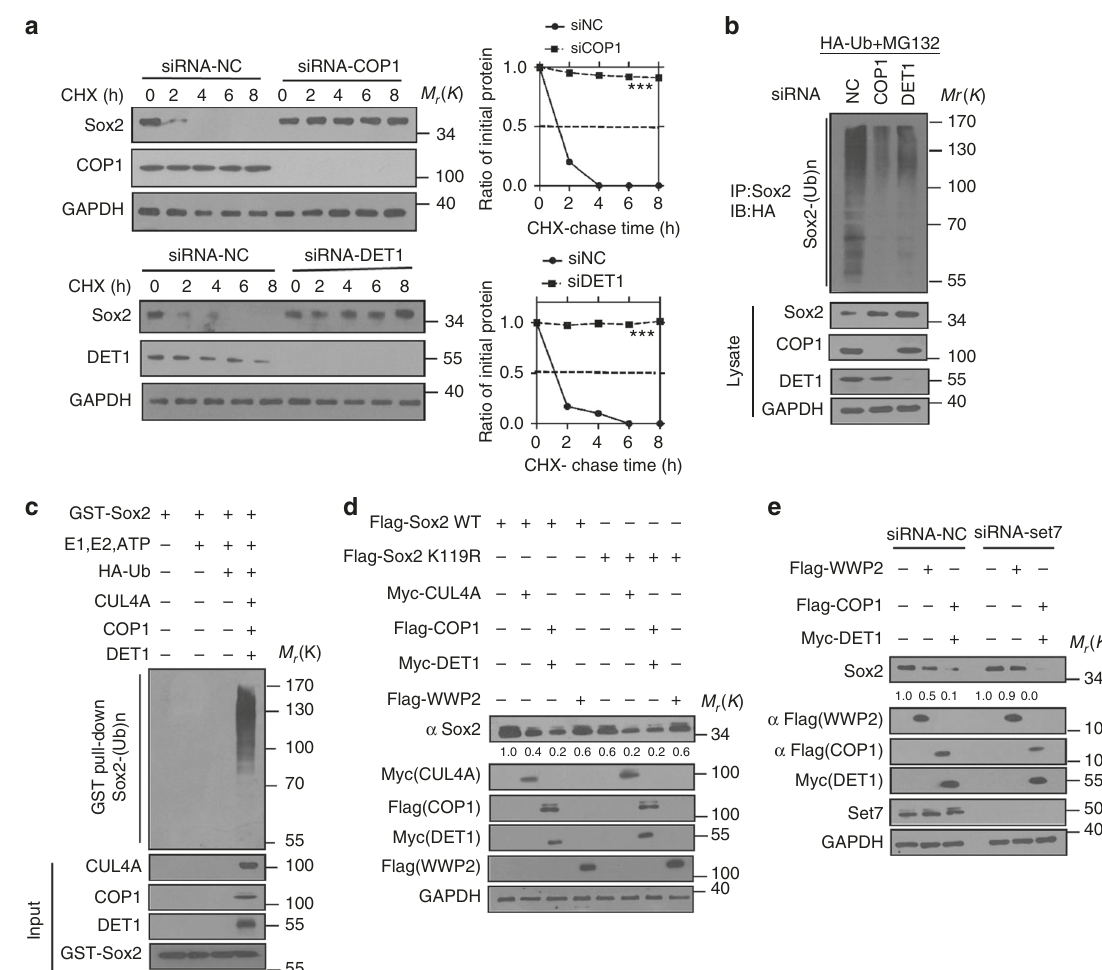
Fig. 4 CUL4A DET1-COP1 ubiquitylates SOX2. a HEK293T cell line with knockdown of COP1 (upper panel) or DET1 (lower panel) were treated with CHX (10 µ g/ml), and collected at the indicated times for western blot. Quanti fi cation of Sox2 level relative to tubulin is shown. Results are shown as mean ± s.d. n = 3 independent experiments. ** P < 0.01, two-way ANOVA test. b HA-Ub was co-transfected with indicated siRNA into HEK293T cells. Cells were treated with MG132 for 8 h before collection. Sox2 was immunoprecipitated with anti-Sox2 and the ubiquitylated Sox2 proteins were immunoblotted with anti-HA. c Cell-free Sox2 ubiquitylation assay. The puri fi ed GST-Sox2, CUL4A, COP1, and DET1 proteins were incubated with commercial E1, UbE2D3 (E2), and ubiquitin for 2 h at 37 °C. The mixtures were subjected to GST pull-down and western blot with anti-His antibody. d Immunoblotting of Flag-Sox2 in cells transfected with indicated constructs. Quanti fi cation of Sox2 level is shown under the blot. e Cells were transfected with indicated siRNA and the